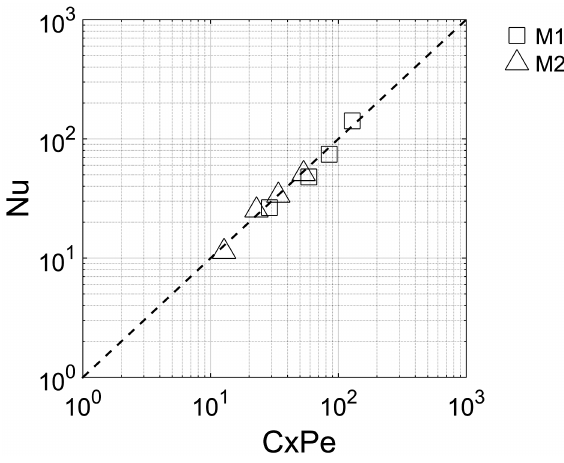
Figure 10. Nusselt number–head loss ratio varying the Peclet num-